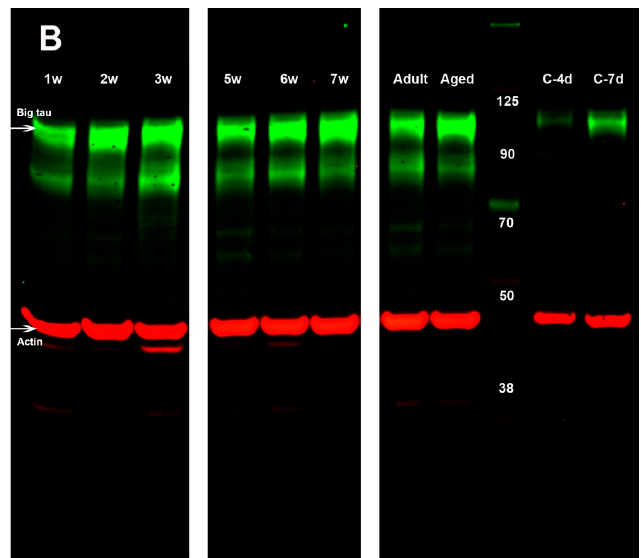
Figure 3. Developmental regulation of Big tau expression in SCG. Western blot analysis of SCG tissue prepared from different ages including 1–3, and 5–7 postnatal weeks, adult at 4 months,